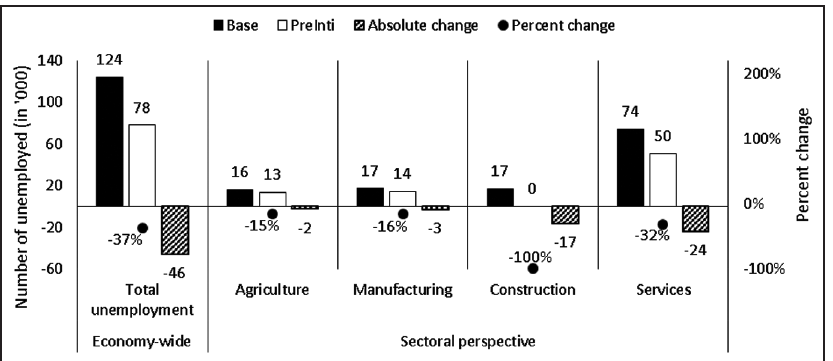
Figure 3 Number of unemployed (thousands, absolute and percentage changes) in the Base and the PreInti scenarios.